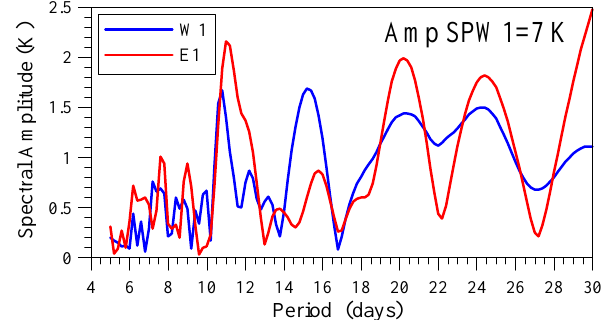
Figure 4 Fig. 4. A 2-D Lomb-Scargle amplitude spectra for zonal wavenum- ber 1 calculated for periods between 5 and 30 days; the spectrum of the E1 waves is in red color, while that of the W1 ones – in blue; the mean amplitude of the SPW1 is noted in the upper right side of the